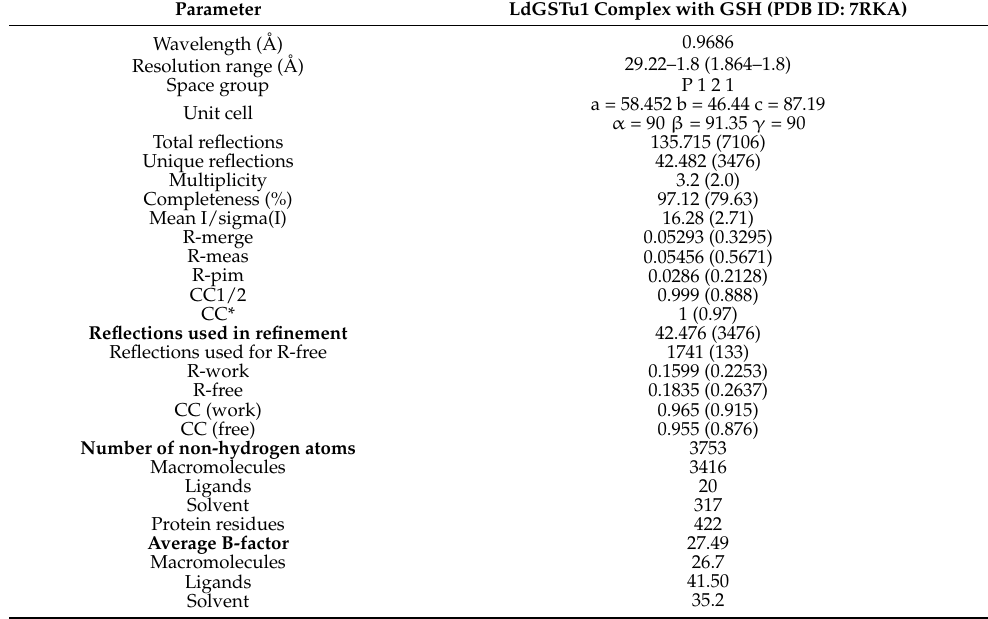
Figure 2. Global structure of LdGSTu1 (PDB ID: 7RKA). ( a ) Ribbon diagram of LdGSTu1 with GSH bound in the active site, showing secondary structural elements and the N-term and C-term domain structures. The N-term domain exhibits the thioredoxin-like fold (residues 1–77) and was complexed with GSH in chain A of the crystal structure. Helices are depicted in cornflower blue, coils in powder blue, and β -strands in yellow. The linker coil (residues 78–88) connecting the polypeptide of the N-term domain to the polypeptide of the C-term domain is depicted in orange. The C-term domain is mainly helical in nature, consisting of five α -helices (medium blue) with coils depicted in powder blue; ( b ) MLP surface diagram of LdGSTu1 monomer with bound GSH in active site. The color scale is cyan for most hydrophilic and passes through white to golden rod for most hydrophobic. In the active site the most hydrophilic location was the G-site with GSH bound and the most hydrophobic region of the active site was the H-site on the C-term side of the active site. The red and purple dashed lines outline the G-site and H-site, respectively. Table 1. Data collection and refinement.